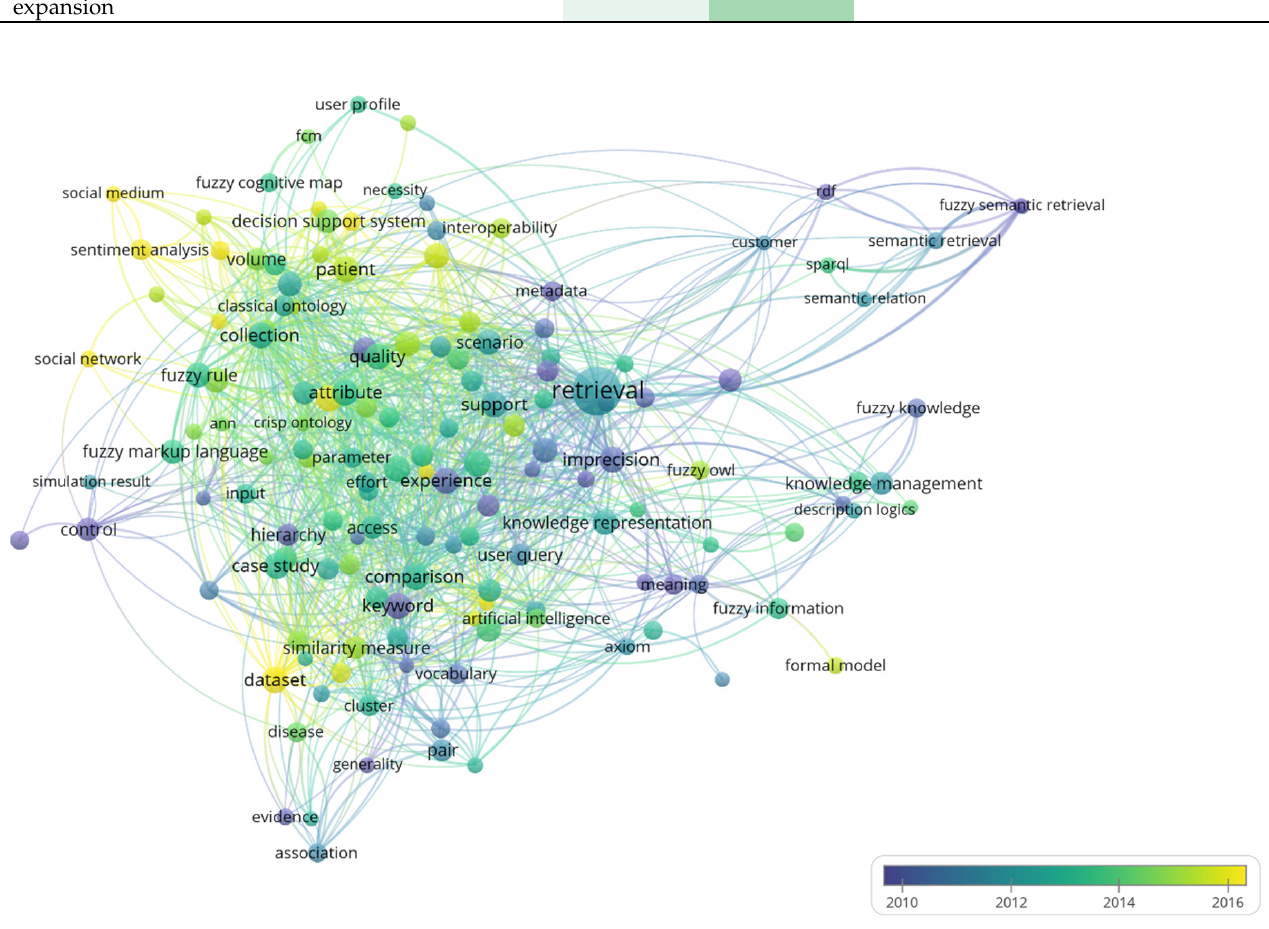
Figure 5. The moderate keywords occurrence according to years.